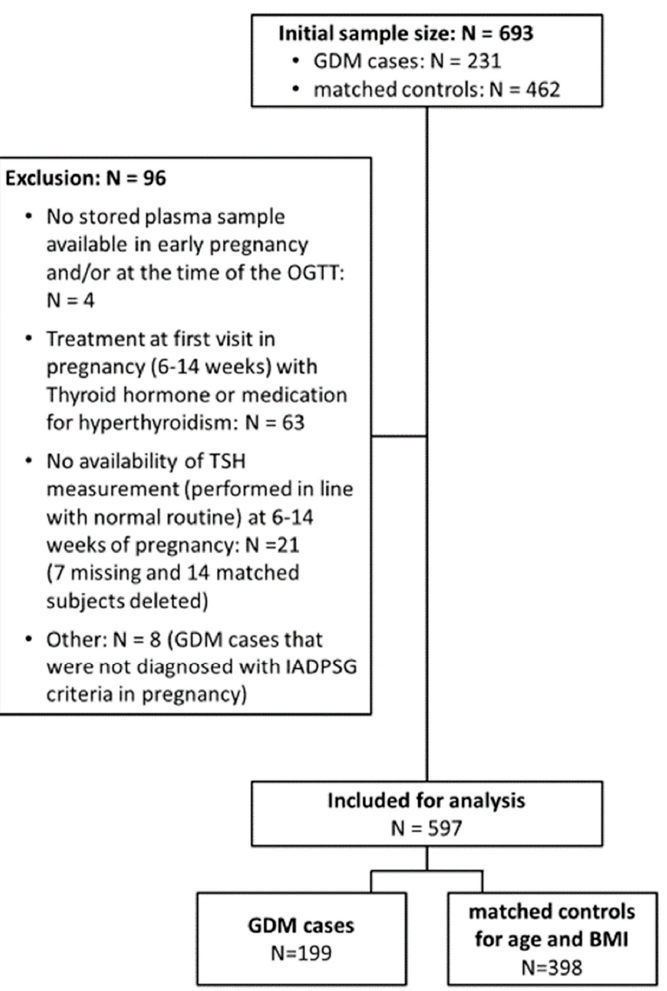
Figure 1. Flow chart of participants included in the sub-analysis. GDM: gestational diabetes melli- tus; OGTT: oral glucose tolerance test; TSH: thyroid-stimulating hormone; IADPSG: International Association of the Diabetes and Pregnancy Study Groups; BMI: body mass index Increases in fT3 and the fT3-to-fT4 ratio were associated with a higher BMI, fasting